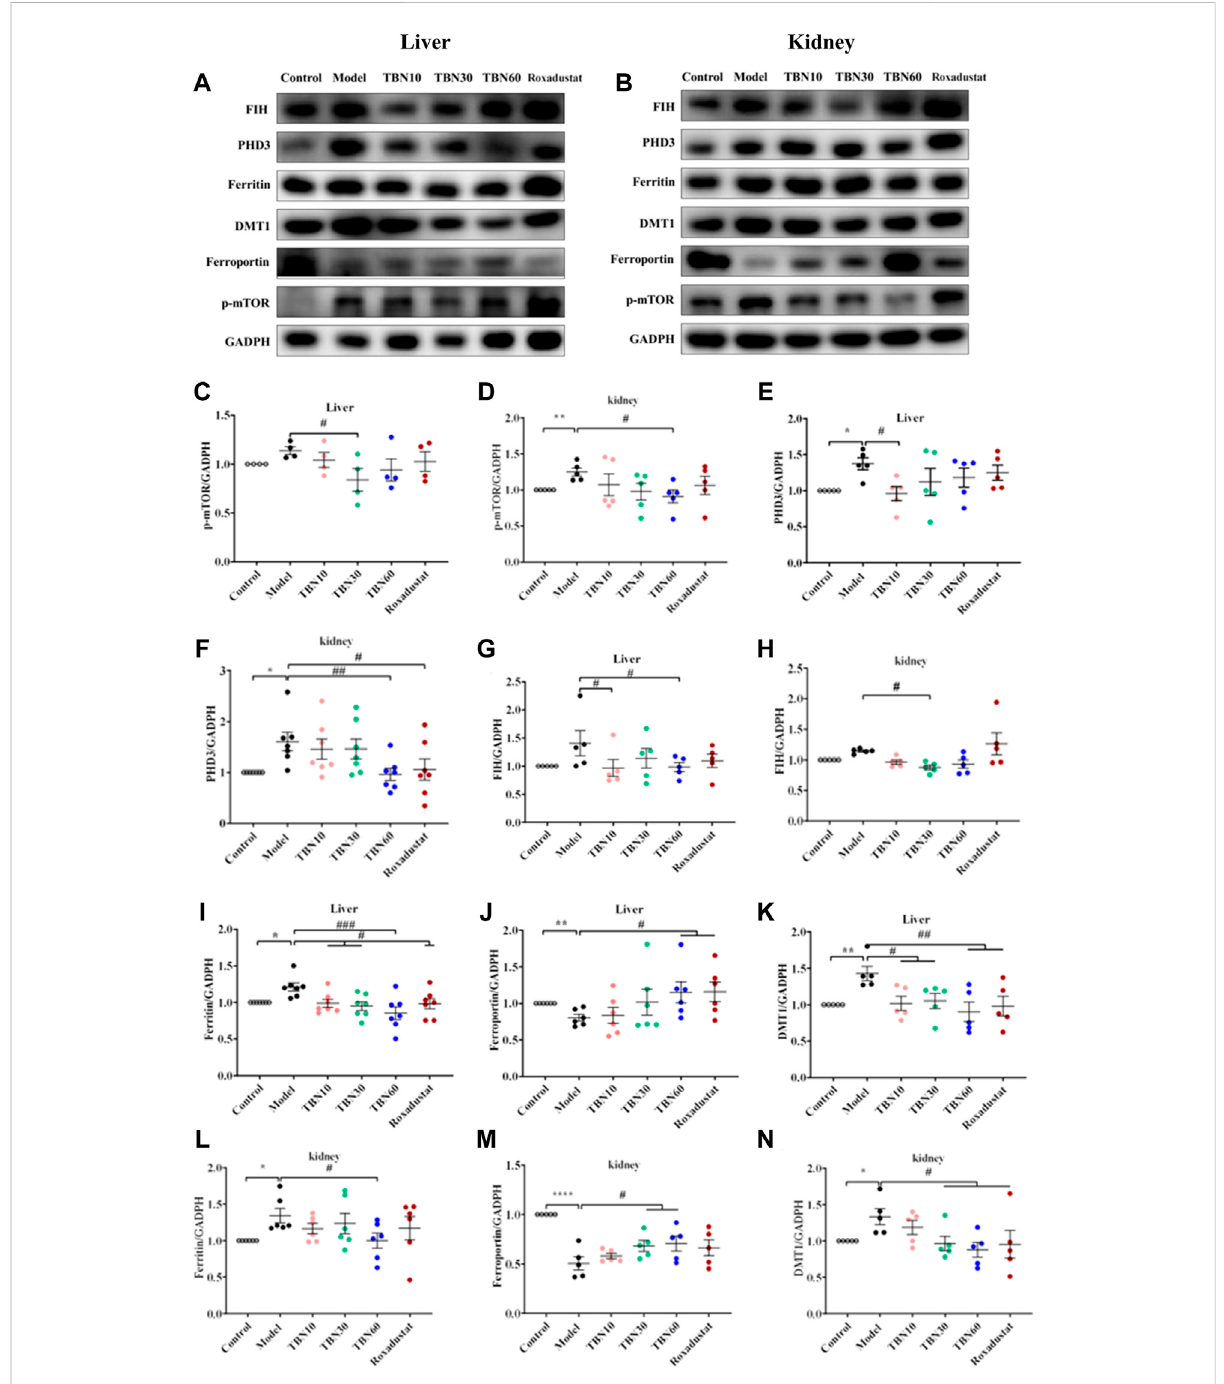
TBN effect in iron metabolism in CDDP-induced C57BL/6J mice. (A – D) Representative western blots of p-mTOR in liver and kidney tissue. (A,B,E – H) RepresentativewesternblotsofPHD3,FIHofliverandkidneytissue. (A,B,I – N) Representativewesternblotsofferritin,FPNandDMT1both in liver and kidney tissue. [ n = 4 – 7 for each group in Figure (A – N) ]. * p < 0.05; ** p < 0.01; **** p < 0.0001 vs. Control; # p < 0.05; ## p < 0.01; ### p < 0.001 vs.vehicle-treated CDDP group. CDDP, cisplatin; FPN, ferroportin;DMT1,Divalent metal transporter-1;FIH,factor-inhibiting HIF.Model: vehicle-treated CDDP